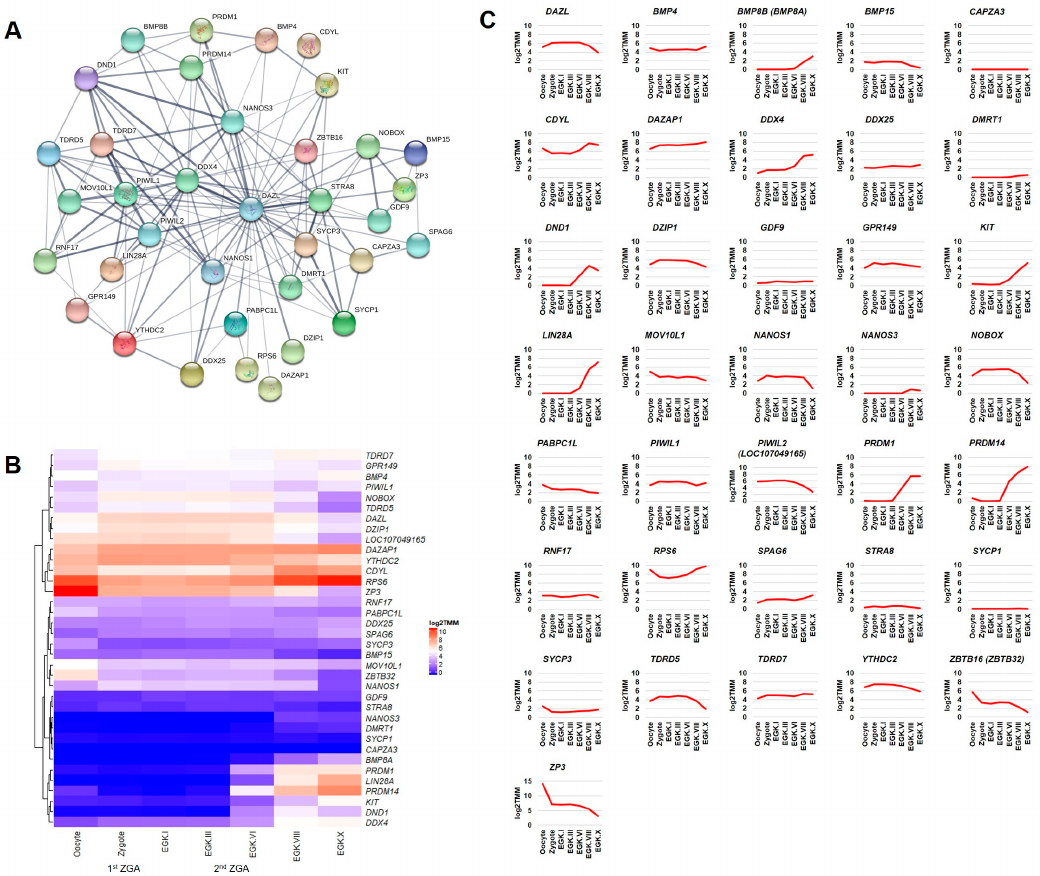
Figure 3. Interaction network and intrauterine embryonic expression of DAZL interacting genes identified in the germ cells development category. The confidence-based direct interaction of DAZL with genes identified in the germ cells development category is prepared using the STRING database ( A ). The expression patterns of DAZL interacting genes (germ cells development category) in the chicken oocyte, zygote, and EGK stage intrauterine embryos (EGK.I to EGK.X) are examined using the WTS data. log2 TMM-normalization is used to better visualize the gene expression through heatmap ( B ) and line graph ( C ).